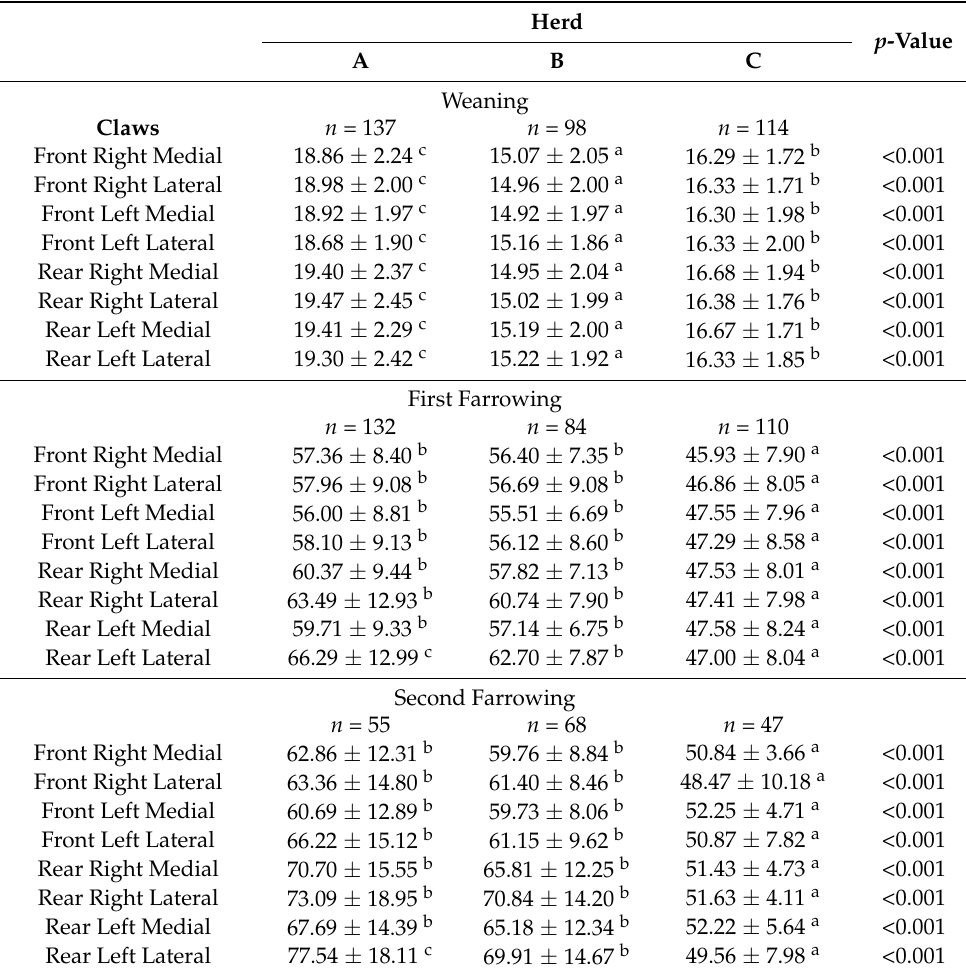
Table 4. Results of dorsal claw length (mm) (mean ± SD) at weaning and at first and second farrowing in replacement gilts of three different genetic lines in three farrow-to-finish herds in Greece. Herd p -Value A B C